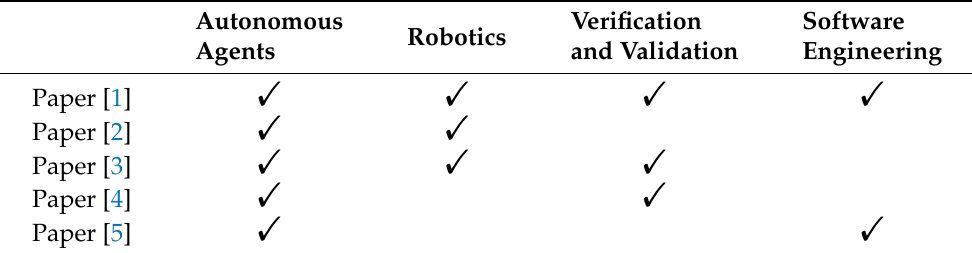
Table 1. Distribution of the papers across the main areas of the Special